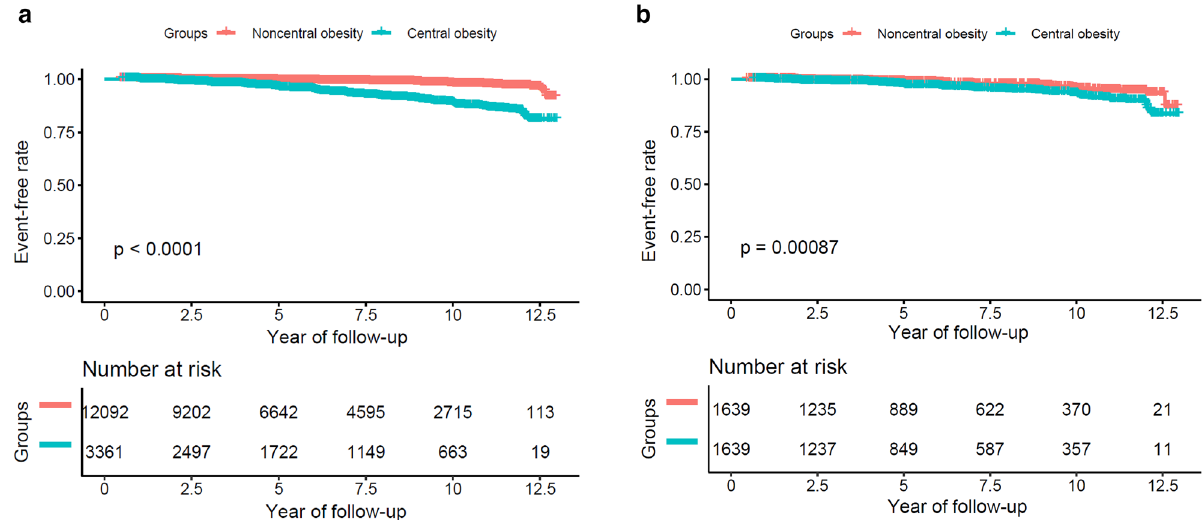
Figure 2. ( a ) Kaplan–Meier analysis of incident diabetes based on Central obesity and Noncentral obesity in the original cohort (log-rank, P < 0.0001). ( b ) Kaplan–Meier analysis of incident diabetes based on Central obesity and Noncentral obesity in the propensity score matching cohort (log-rank, P = 0.00087).